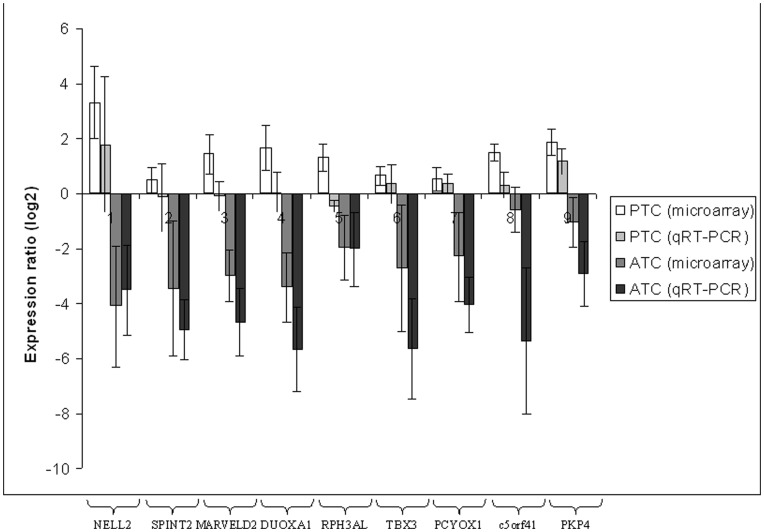
Validation of the 9 genes signature by qRT-PCR on 5 new PTC and 5 new ATC.The microarray expressions is also represented. Log2 ratios represent the expression ratios of the genes in the tumors versus a pool of 23 normal thyroid tissues.